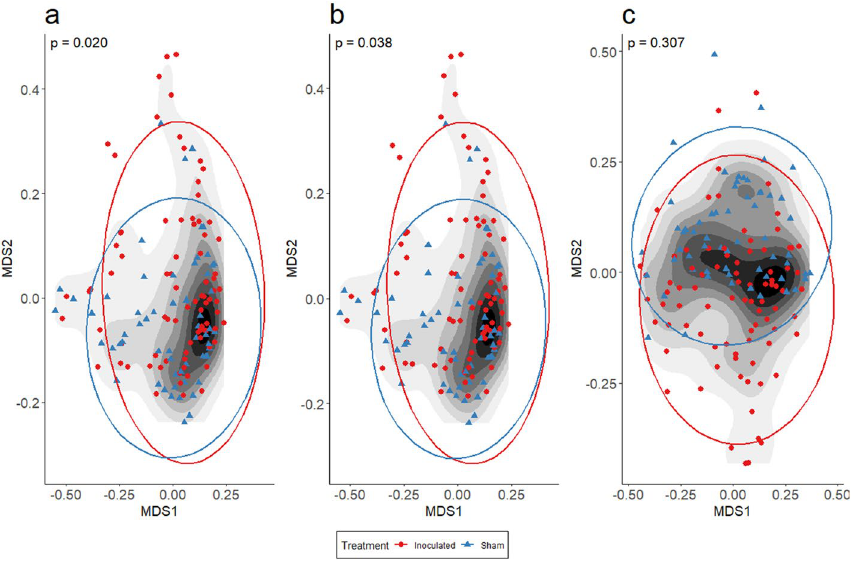
Figure 4. Inoculation results in changes to host microbiome composition which are partially explained by differences in richness. Nonmetric multidimensional scaling (NMDS) ordinations representing host microbiome composition of sham and inoculated snakes throughout the experiment measured using ( a ) Jaccard, ( b ) Bray–Curtis, and ( c ) Raup-crick dissimilarity. Multiple indices were used in order to discern patterns that were shared, or not, across indices. Differences in composition between sham and inoculated treatments are indicated by ellipses (95% SE); time is represented by contours with lighter colors corresponding to later sampling events (weeks). ( a , b ) The interaction of time and treatment group (PERMANOVA p -values within each panel) was significantly predictive of composition for both the Jaccard and Bray–Curtis index, suggesting that average composition of the host microbiome varied depending on treatment across time. ( c ) The interaction term was not significantly predictive of community composition for the Raup-Crick metric, which explicitly accounts for differences in composition that are likely to occur due to differences in richness alone. Changes in richness following infection with O. ophidiicola may be a key mechanism resulting in alterations to the host microbiome.